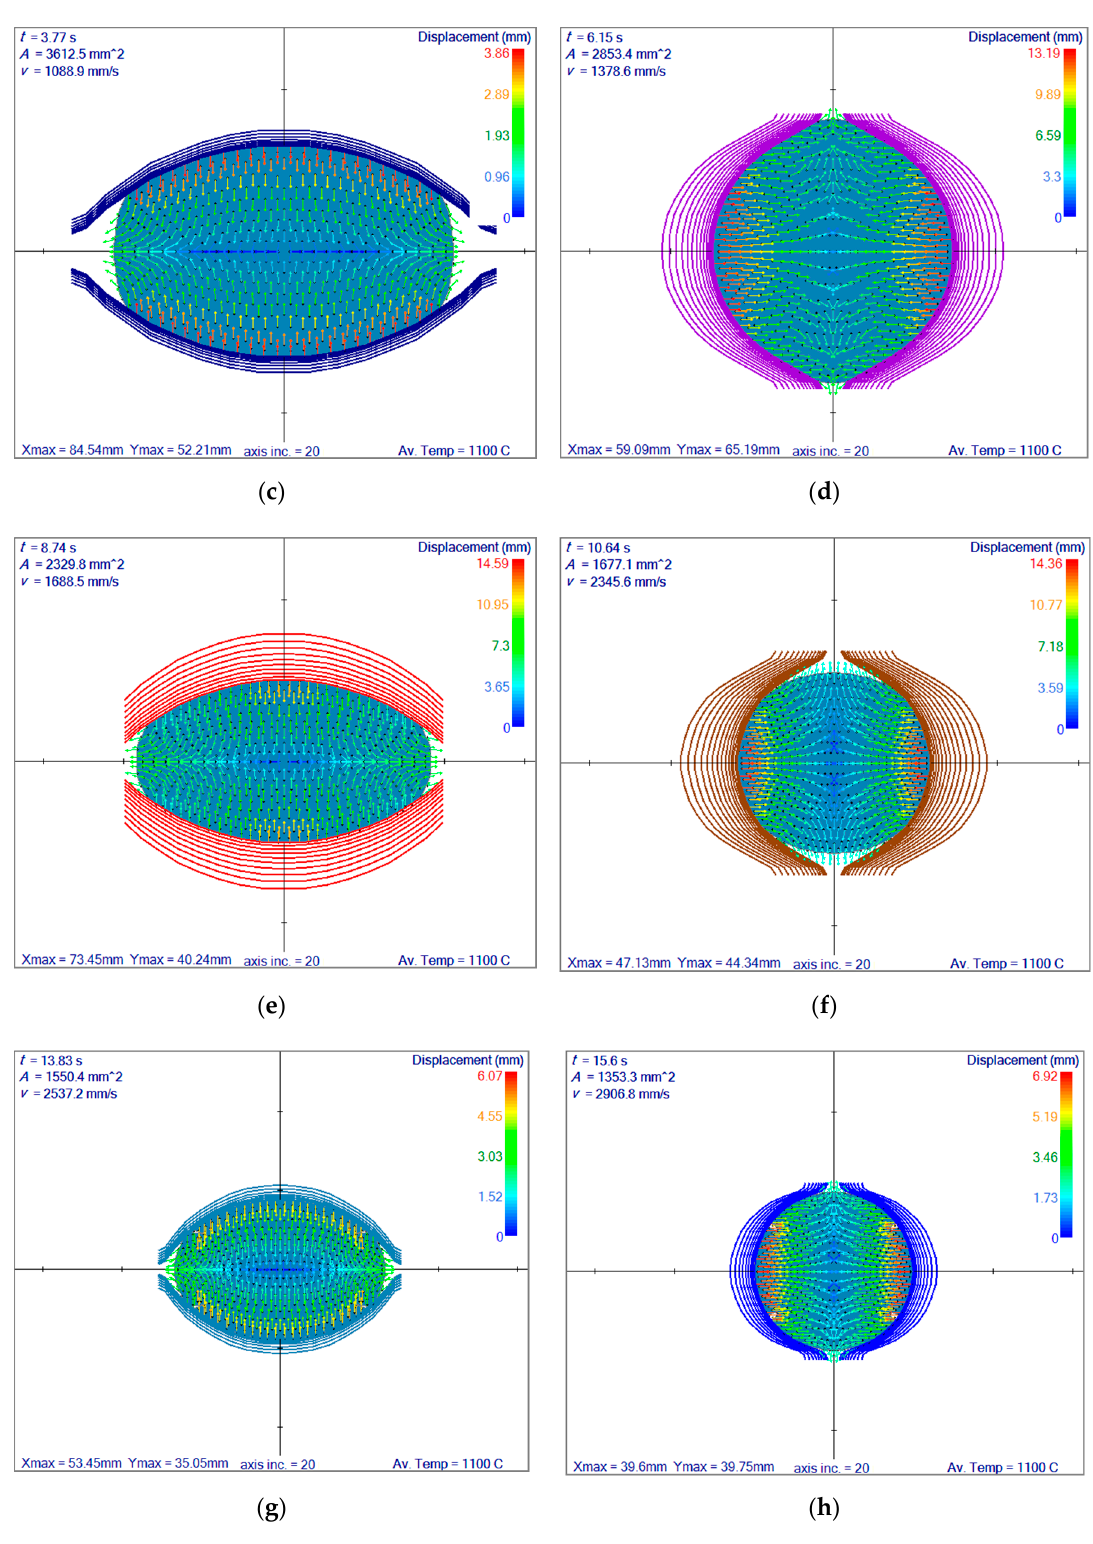
Figure 9. Oval rolling simulation results in terms of displacement fields. ( a ) After first pass, ( b ) after second pass, ( c ) after third pass, ( d ) after fourth pass, ( e ) after fifth pass, ( f ) after sixth pass, ( g ) after seventh pass.